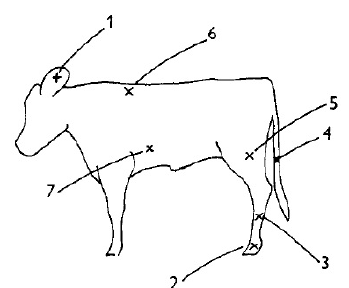
Figure 1. Skin surface measured throughout cold challenge. Ears (1), foot (2), shin (3), tail (4), muscular part of the thigh (5), prescapular (6), and thorax wall (7). Adapted from Gonzalez-Jimenez and Blaxter [19].